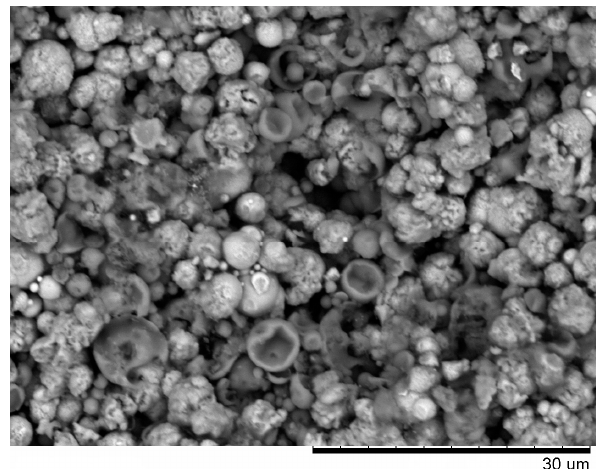
Figure 5. BSE image of the flat end of the disk-shaped compact Spark Plasma Sintered at 600 °C under pressureless conditions from a loosely packed Fe-40at.%Al mixture.